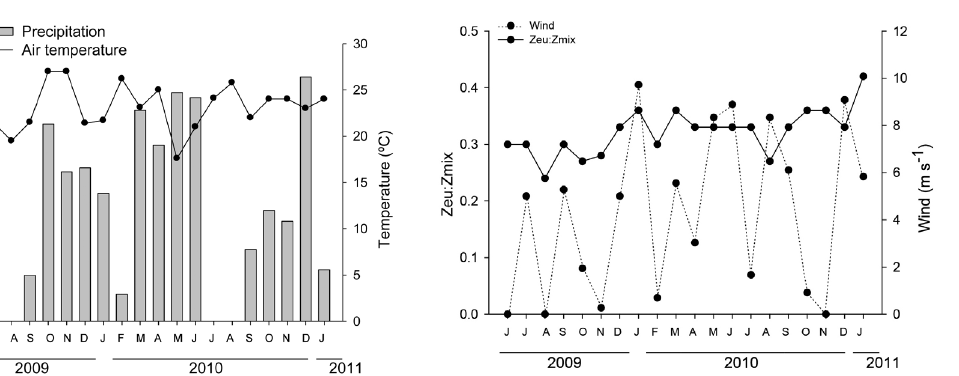
Lake, from June/2009 to January/2011.